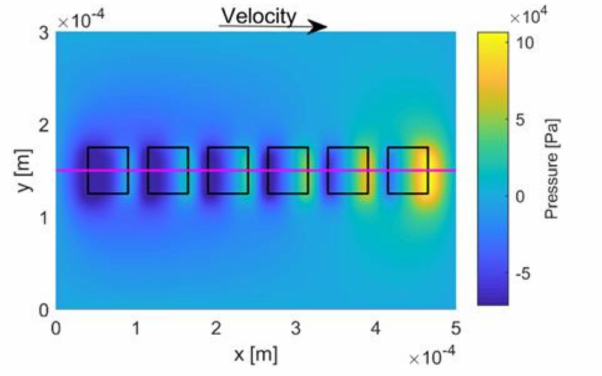
Figure 12. Pressure contour of the full texturing configuration. Square dimples with side 50 µ m and depth 10 µ m. Gap 5 µ m, sliding velocity 5 m /